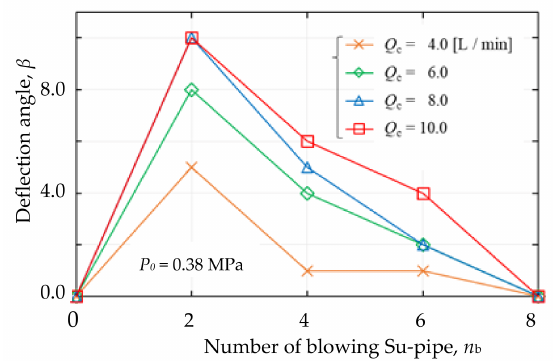
Figure 13. Deflection angle, β , and the number of Su-pipes blowing, n b ( P 0 = 0.38 MPa, Q c = 10 [L/min]): The deflection angle has a maximum value of β = 10 ◦ at n =